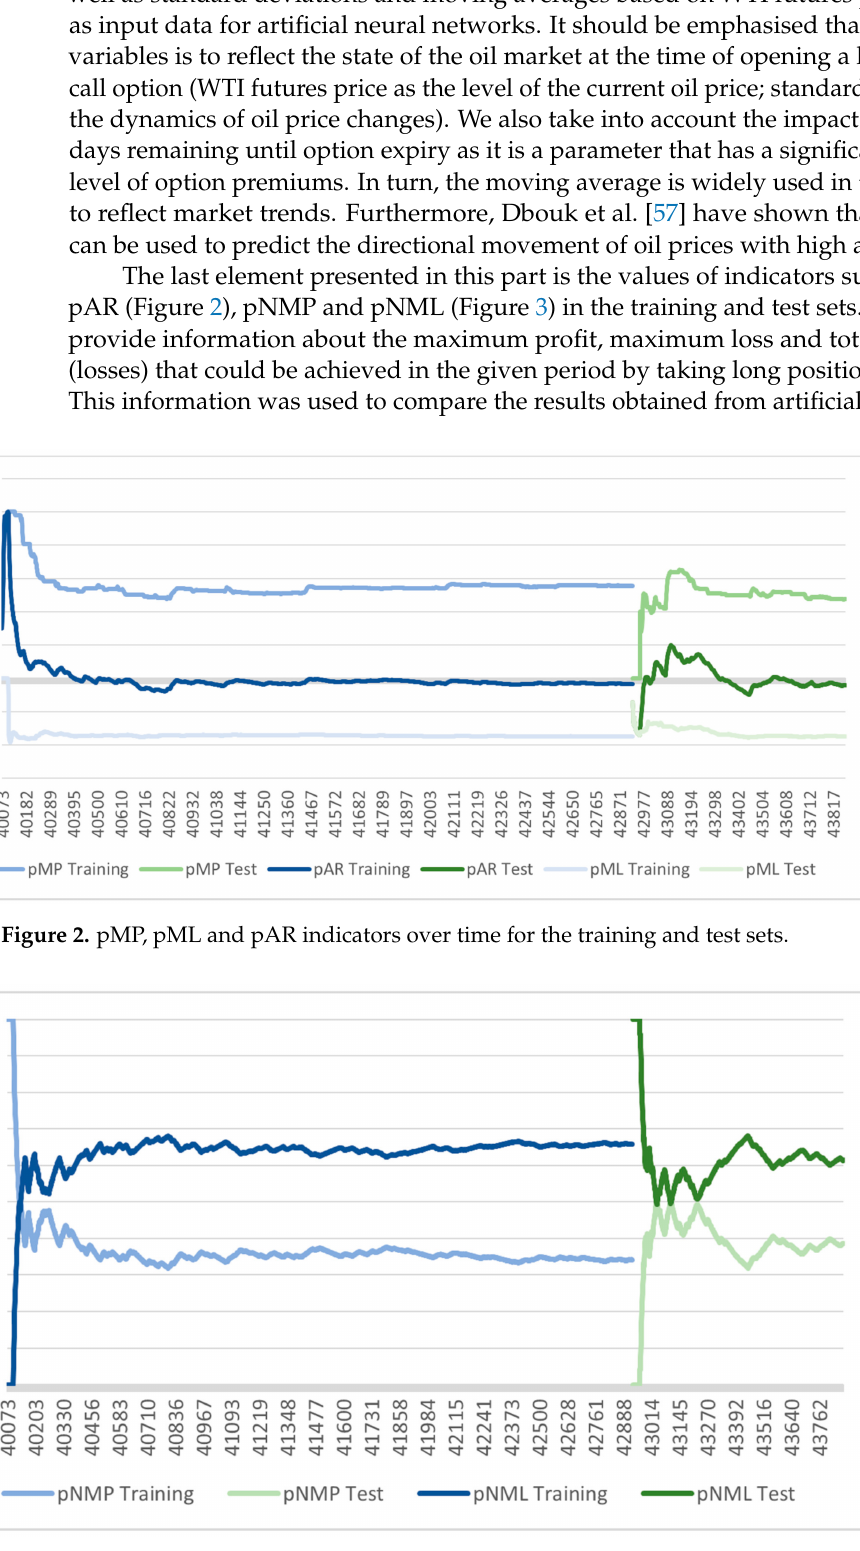
Figure 3. pNMP and pNML indicators over time for the training test